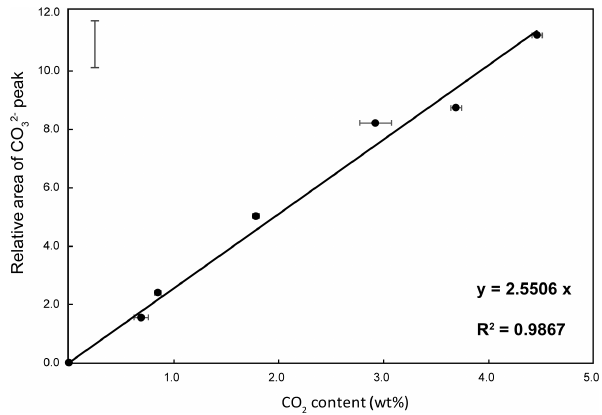
Figure 3. Raman calibration line: plot of the relative area of the CO 2 − peak of the Raman spectra ( A compX /A tot in Eq. 1) as a func- 3 tion of the CO 2 concentration of the reference glasses. The error bar represents the 95% confidence